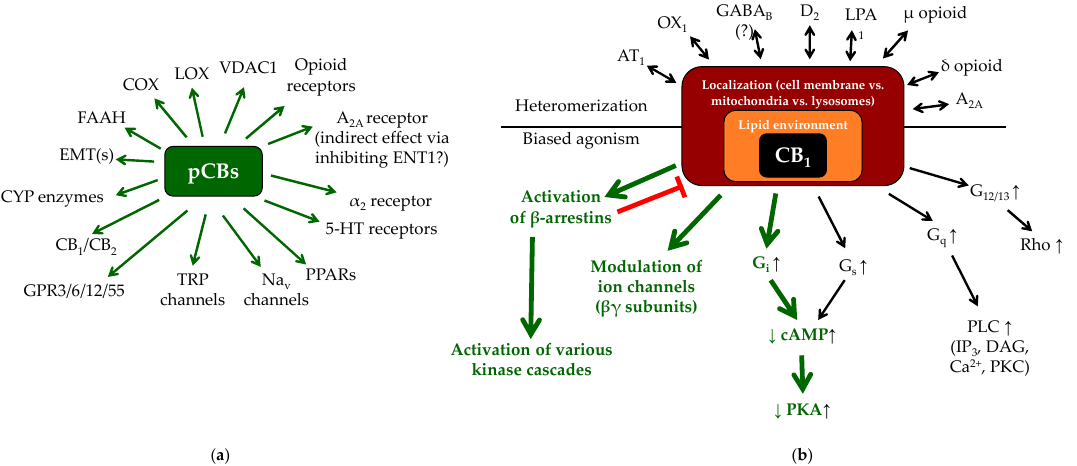
Figure 2. Examples of the context-dependent complexity of the cannabinoid signaling. ( a ) Overview of the most important potential targets of the phytocannabinoids (pCBs), which can be concentration-dependently activated/antagonized/inhibited by these molecules. Each pCB can be characterized by a unique molecular fingerprint, and every pCB was found to interact with only a subset of potential targets shown on panel ( a ). Importantly, the interactions can even result in opposing outcomes (e.g., THC is a partial CB 1 agonist, whereas CBD is a CB 1 antagonist/inverse agonist), making prediction of cellular effects of the pCBs even more difficult. ( b ) The actual biological response, which develops following the activation of CB 1 receptor depends on several additional factors, including biased agonism [31,32,65–73], possible receptor heteromerization [32,74–80], localization (i.e., cell membrane vs. mitochondria vs. lysosomes [81–83]), as well as the composition of the lipid microenvironment of the given membrane [58,84]. Green arrows on panel (b): the most common signaling pathways of CB 1 . Note that besides CB 1 , biased agonism is well-described in case of CB 2 , GPR18, GPR55 and GPR119 as well, whereas CB 2 was proven to heteromerize with, e.g., C-X-C chemokine receptor type 4 chemokine receptor (CXCR4), or GPR55 (for details, see the above references). The question mark indicates that functional heteromerization of CB 1 and GABA B receptors is questionable. AT 1 :